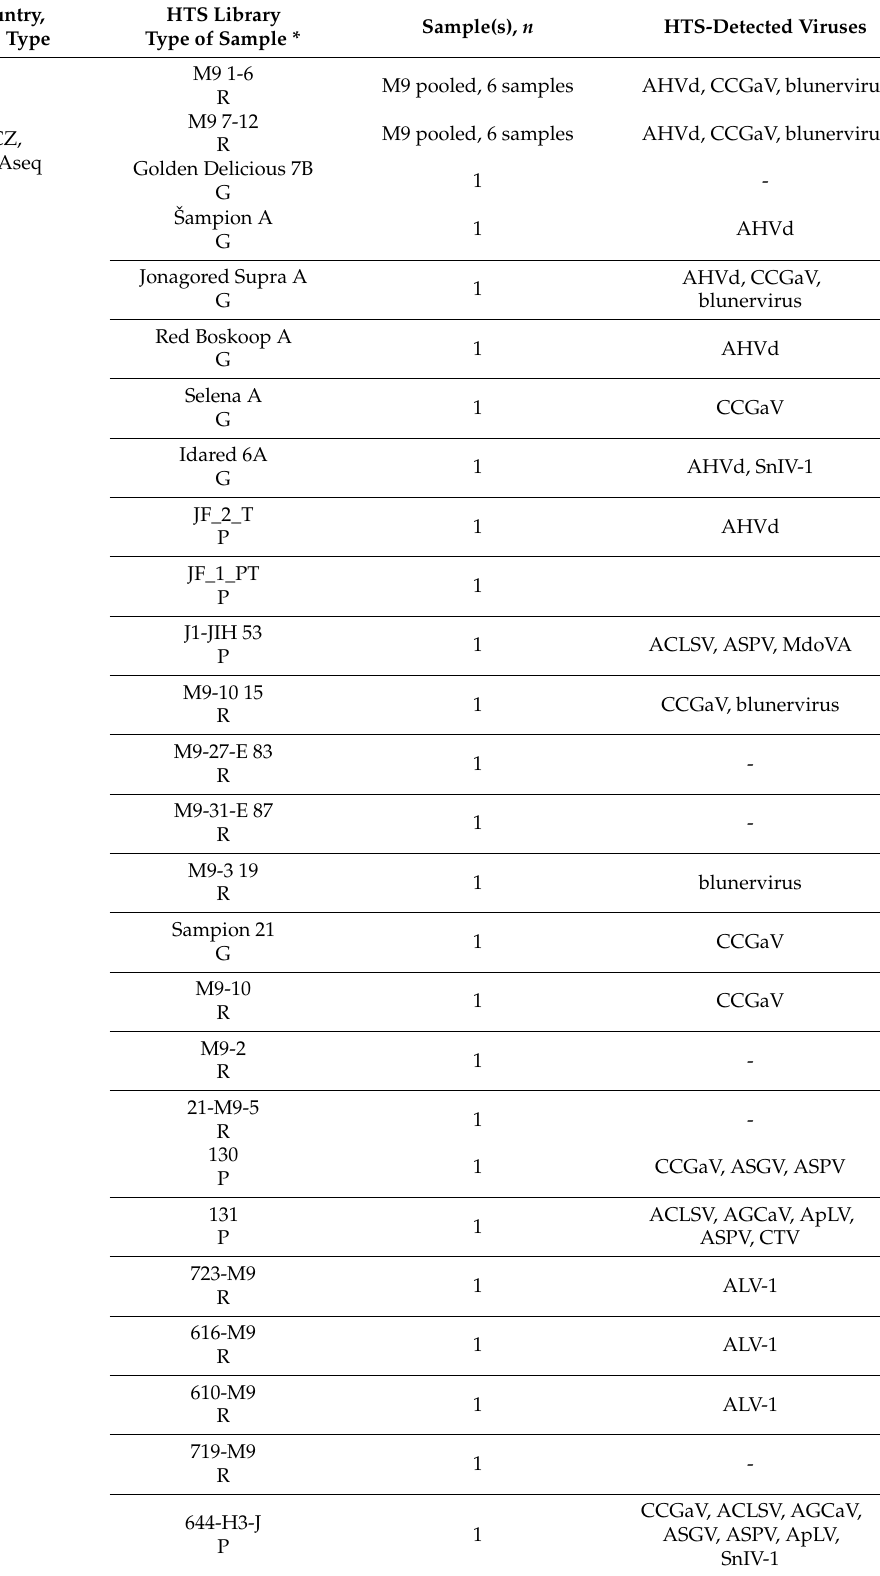
Table A1. Summary of HTS-tested